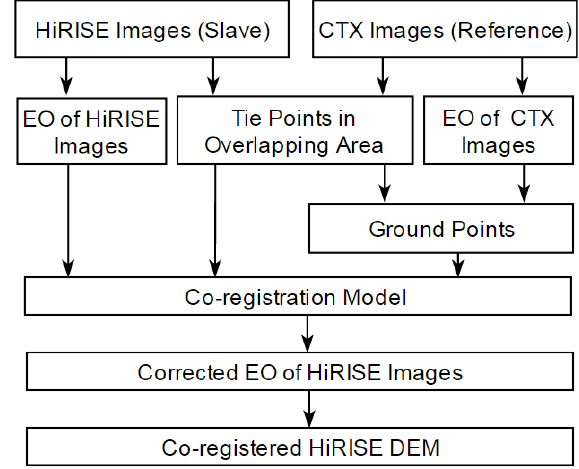
Figure 3. Framework of the co-registration